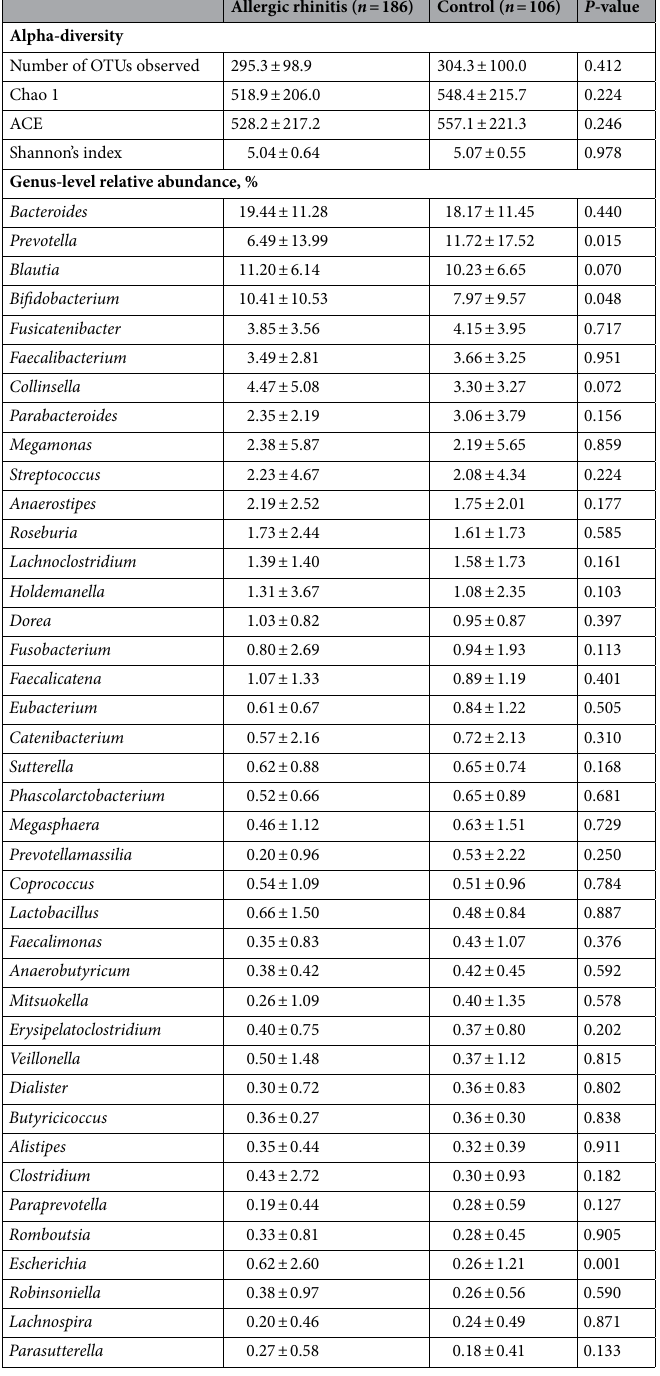
Table 3. Gut microbial characteristics and allergic rhinitis. Values are shown as the mean ± standard deviation. P -values were calculated using the Wilcoxon rank sum test. No adjustments were made for statistical tests shown in this table. OTU indicates operational taxonomic